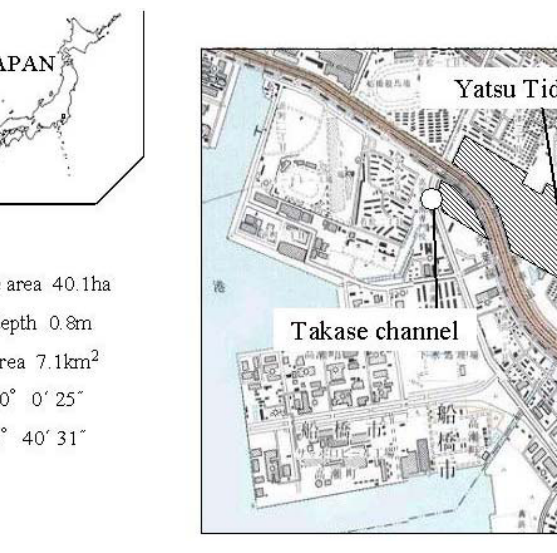
FIGURE 1 . Location of Yatsu tidal flat and sampling